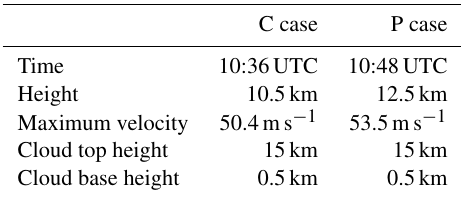
Table 3. Domain-averaged properties of hydrometeors. Table 4. Comparison of convective